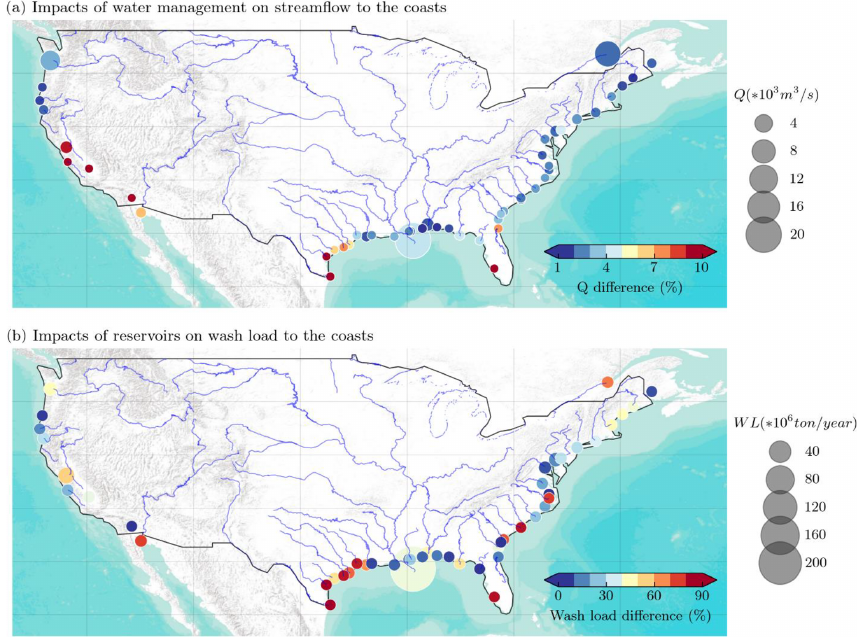
Figure 13. Impacts of reservoirs on (a) streamflow and (b) wash load to the coasts. Each dot represents the lat–long grid at the river mouth of a river system. The larger the dot size, the larger the freshwater or suspended sediment discharge simulated with Sim_wm_trapping. The color of each dot represents the percentage of freshwater or suspended sediment discharge that is reduced by water management or reservoirs, i.e., (sim_nat − Sim_wm_trapping) /